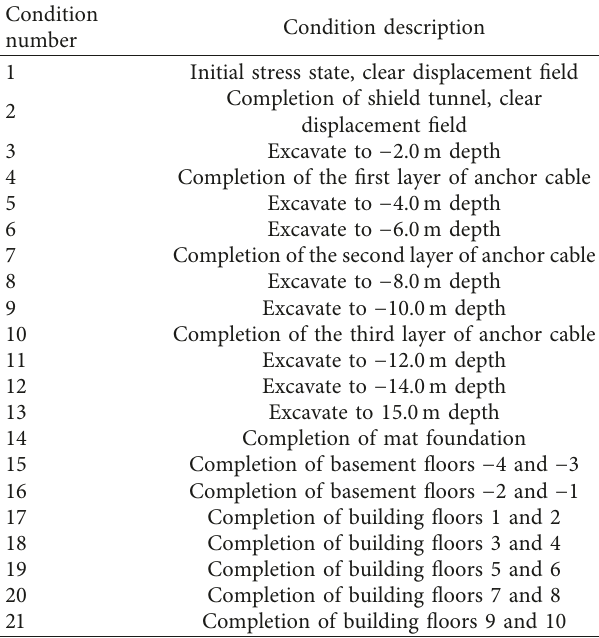
Table 7: Numerical simulation conditions for Scheme 3.